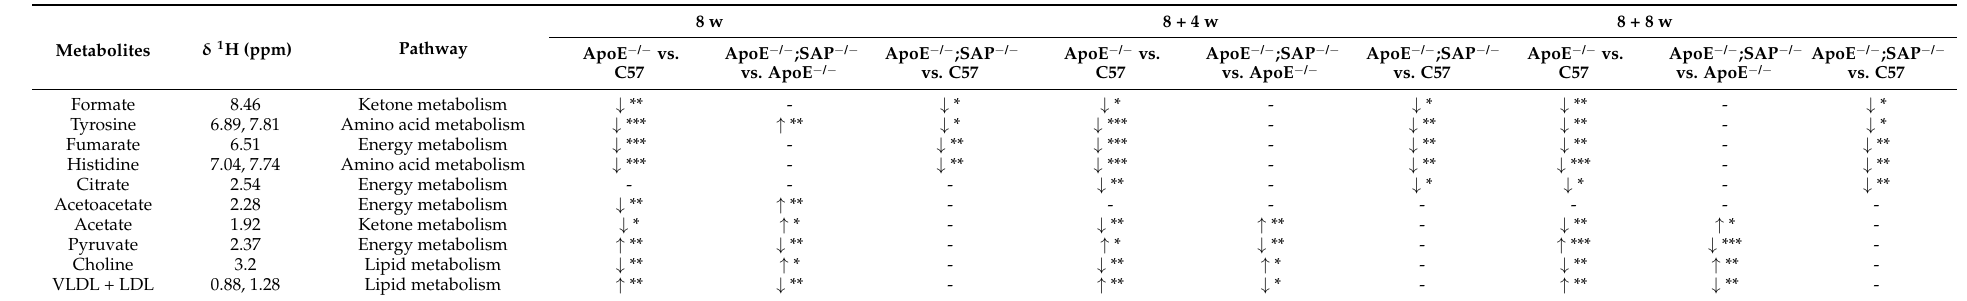
Table 1. Statistical analysis of potential biochemical markers in serum of C57 mice, ApoE − / − mice and ApoE − / − ;SAP − / −